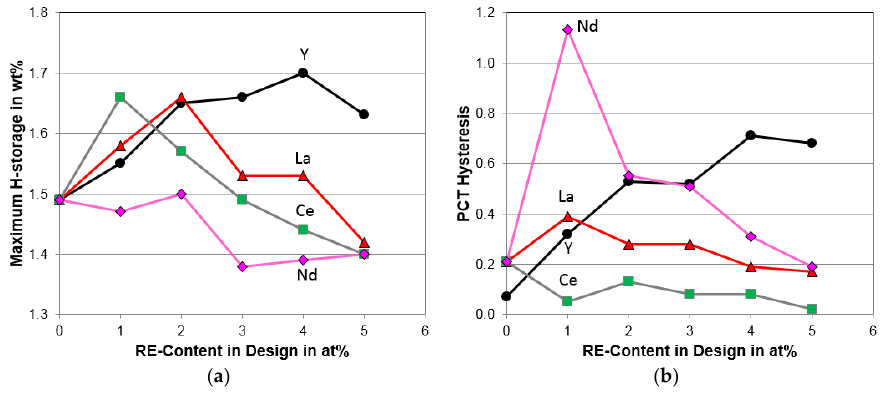
Figure 7. Evolutions of ( a ) maximum H-storage capacity and ( b ) PCT absorption–desorption hysteresis with increasing RE-content in the design.